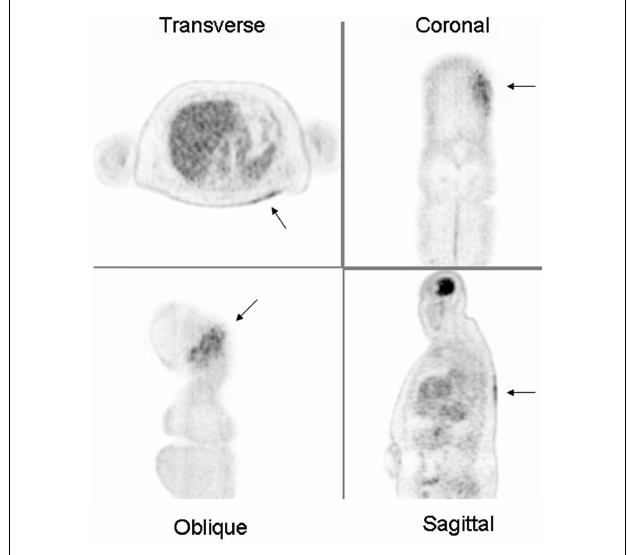
FIGURE 1 | 18 FDG PET images demonstrating a dermatomal distribution of increased metabolic activity in the left upper back (arrows). These findings were consistent with active Varicella zoster infection